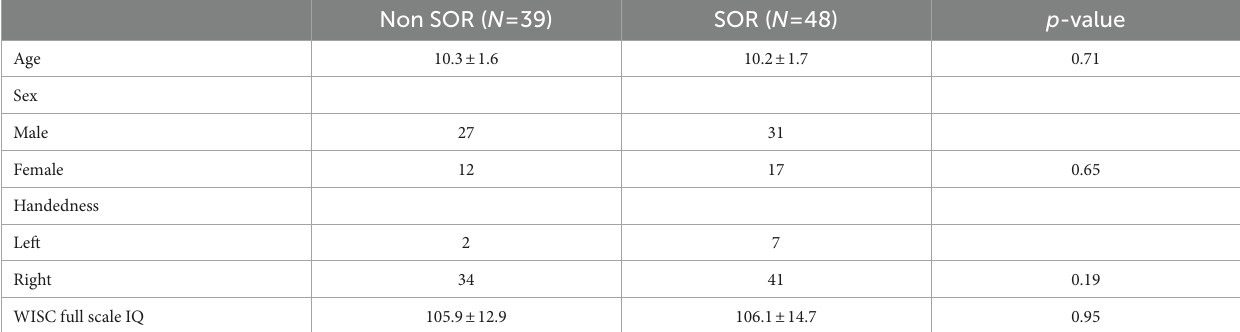
TABLE 2 Demographic characteristics of children with non-SOR and SOR, continuous variables are reported as mean ± SD while categorical data is represented with absolute numbers, unpaired t test is used for continuous data while Pearson chi square test is used for categorical